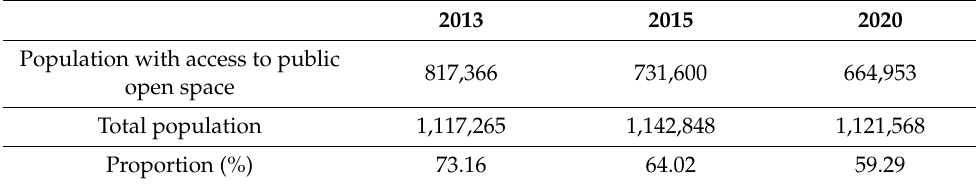
Table 5. Population with access to open public spaces from 2013 to 2020 in Guilin.